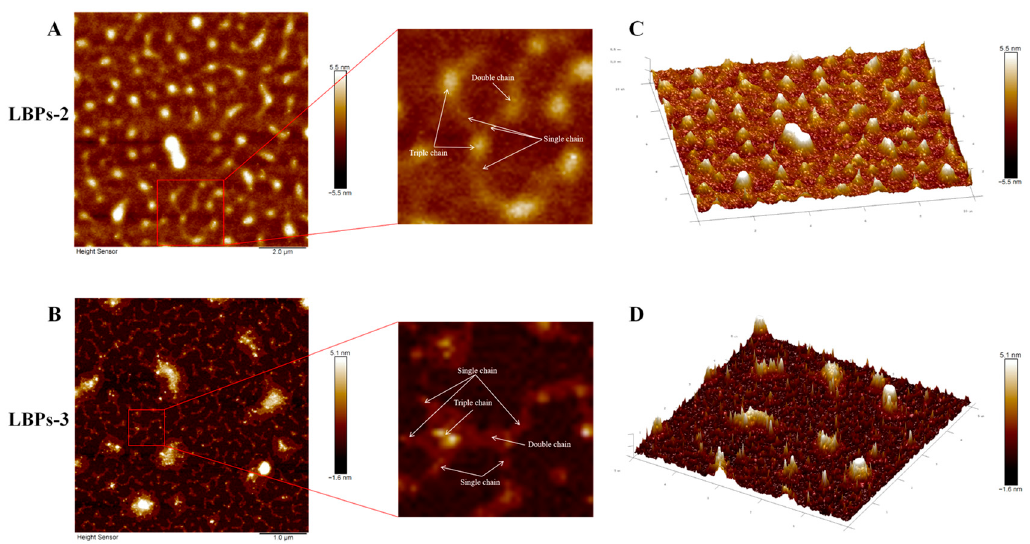
Figure 6. AFM planar images (( A , B ): 10 µ m), AFM 3D images (( C , D ): 10 µ m) of LBPs-2 and LBPs-3. The 1 H NMR, 13 C NMR, HSQC, HMBC, and 1 H- 1 H COSY data on LBPs-2 and LBPs-